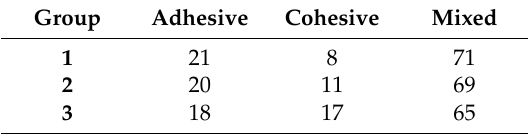
Table 3. Distribution (%) of failure modes of each group. Group